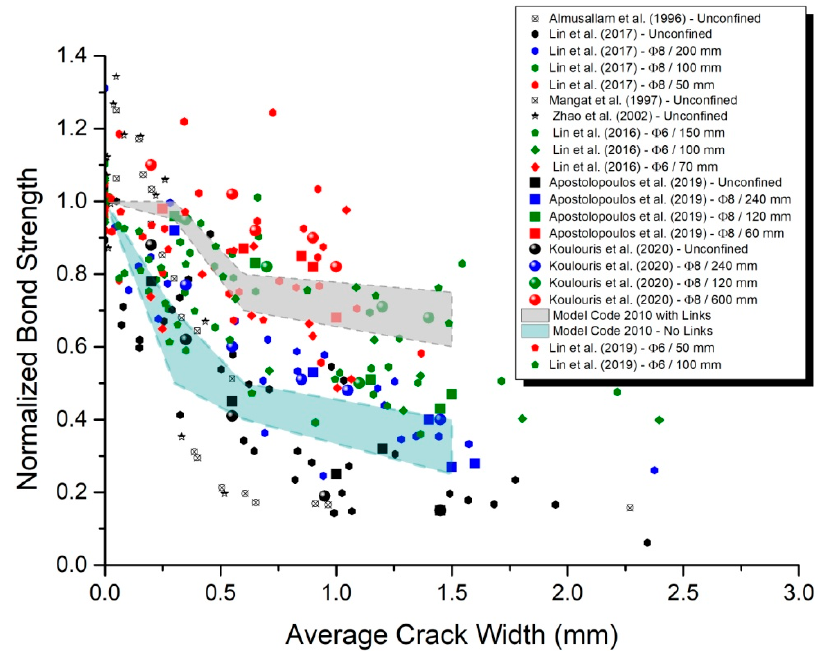
Figure 11. Normalized bond strength due to corrosion as a function of average surface crack width on concrete, data from [16,17,23,36,39,41,44,45].